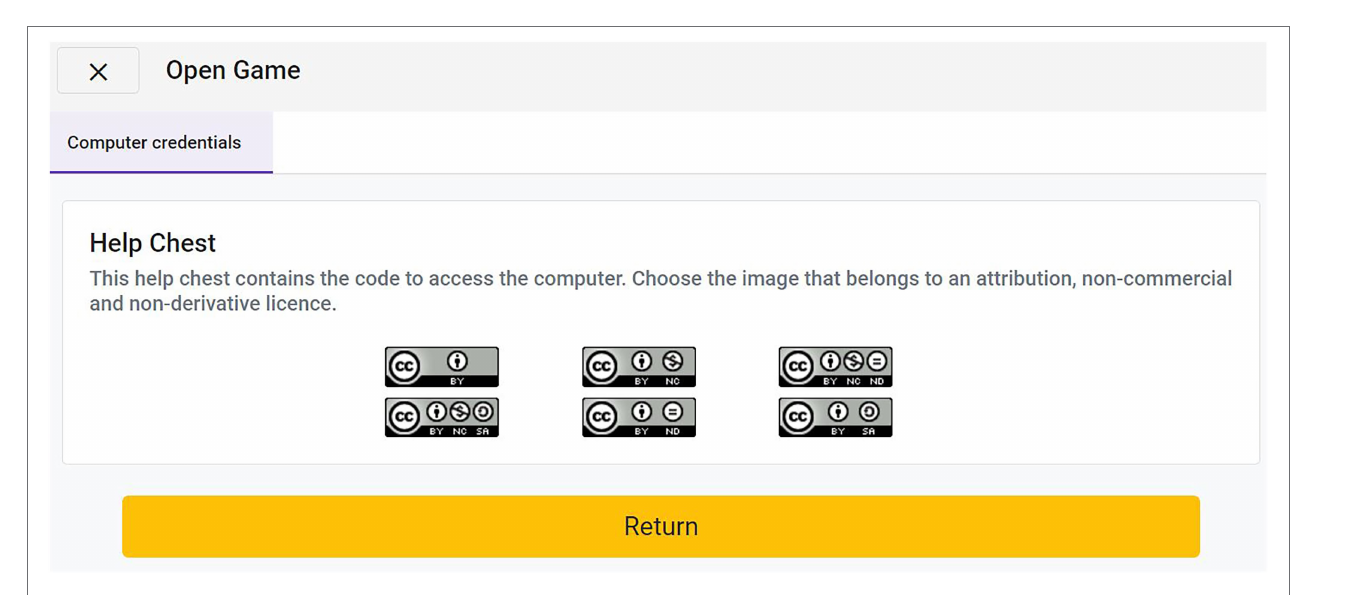
FIGURE 9 | Puzzle to reach level 3 in Module A, in Auditorium